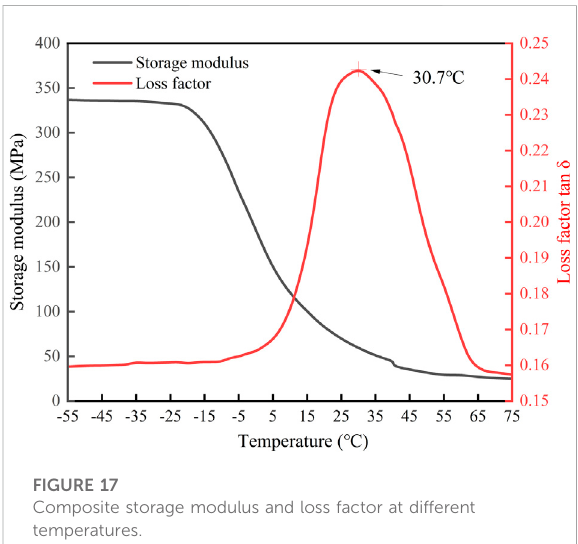
FIGURE 17 Composite storage modulus and loss factor at different